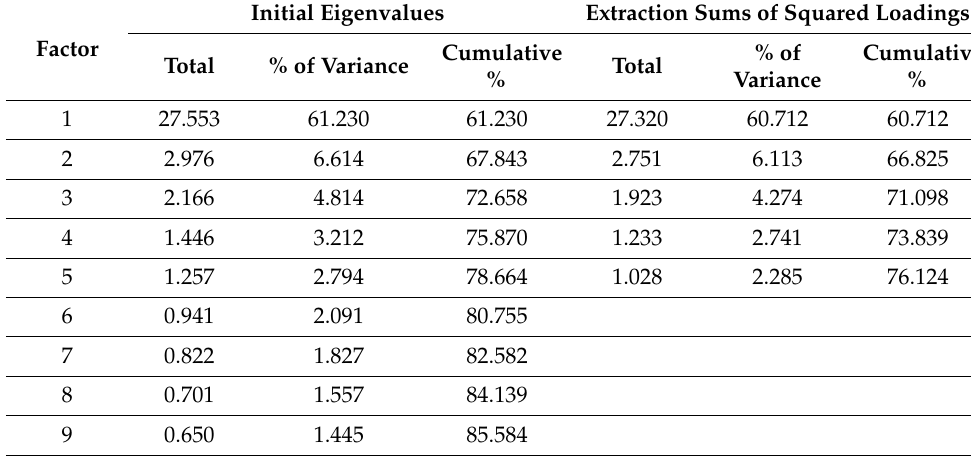
Table 6. Total variance explained for